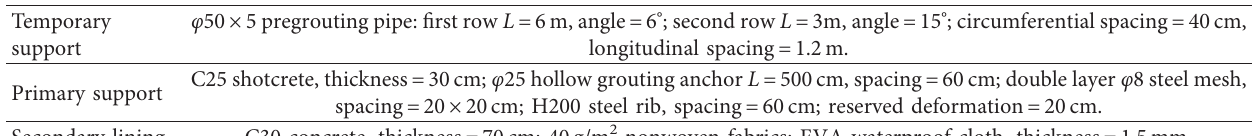
Figure 3: Supporting parameters of tunnel portal. Table 1: The support system of the tunnel portal.